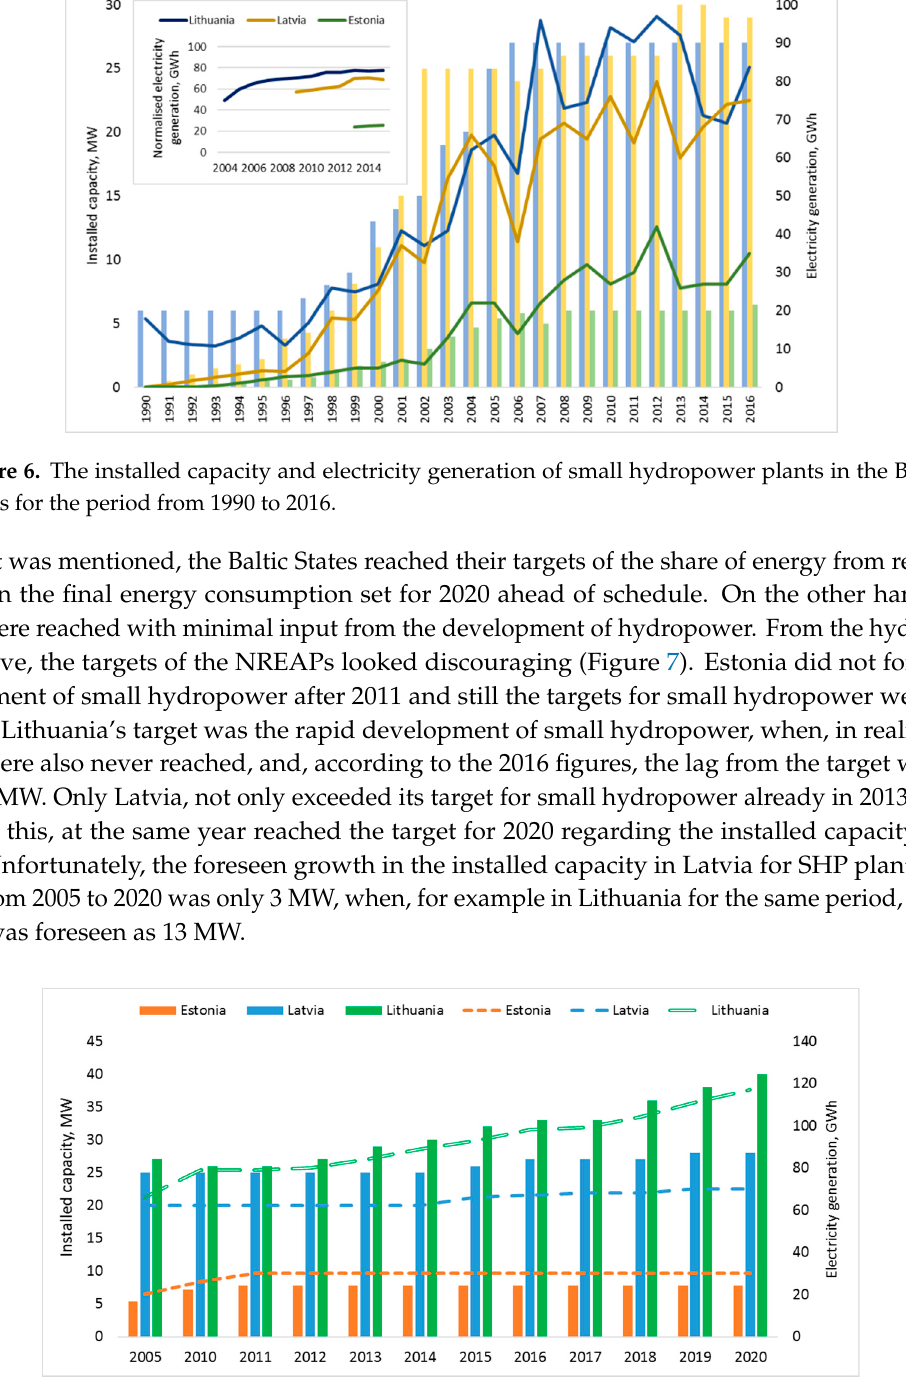
Figure 7. The targets of the national renewable energy action plans (NREAPs) for small hydropower development in the Baltic States.